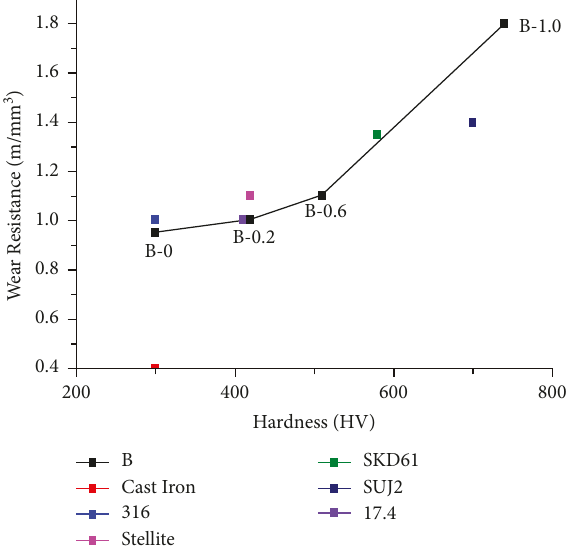
Figure 20: Wear resistance vs. hardness curve for CuCoNi- CrAl 0.5 Fe alloy with varying boron quantity [27].